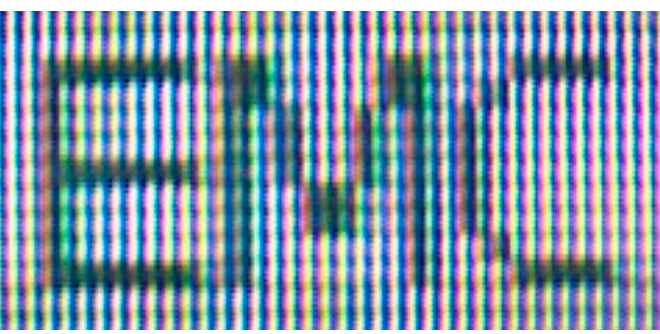
Appl. Sci. 2019 , 9 , x FOR PEER REVIEW Figure 8. Character string displayed on monitor (800 × 600 pixels). Figure 8. Character string displayed on monitor (800 × 600 pixels).